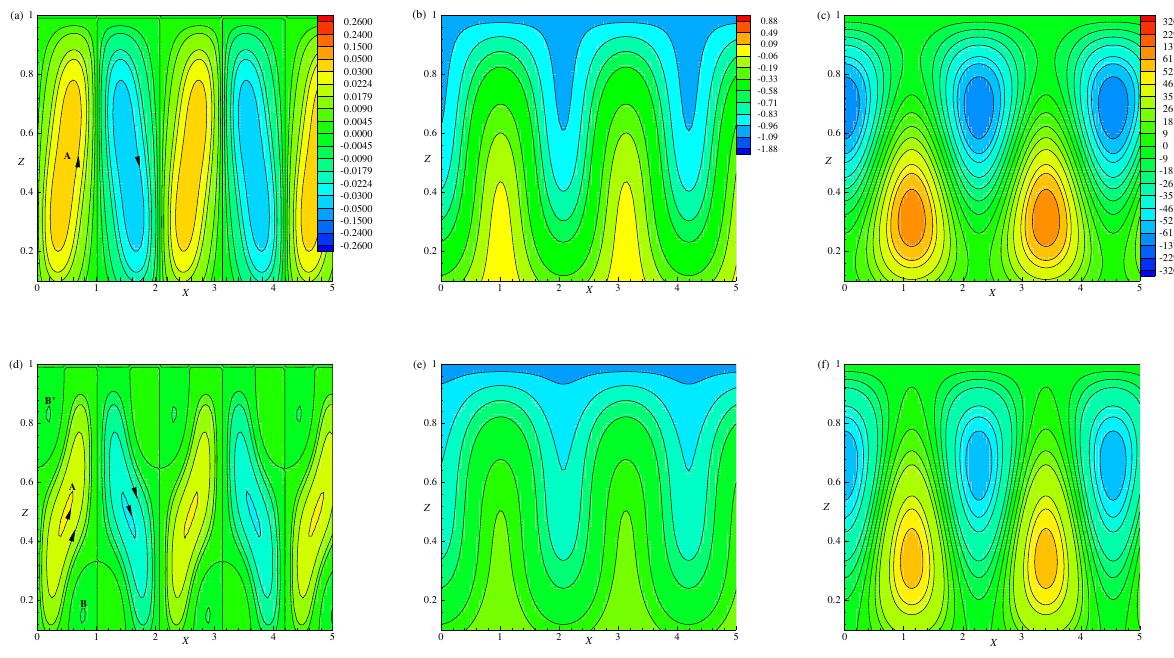
of streamlines are tilted towards the right side by retaining the flow orientation in the considered range of 0 ≤ X ≤ 1. The absolute maximum and minimum values of circulation strength are 0.03585 and − 0.03585, respectively. Figure 9d–f are plotted for ψ = − 0.03, with the same fixed set of parameters and contour lines defined in Figure 9a–c. In Figure 9d, the flow pattern in the range 0 ≤ X ≤ 1 becomes more deformed by creating the two additional vortices B and B (cid:48) at the top and bottom limits, respectively, and on either side of the primary cell. The circulation strength of the two vortices, B and B (cid:48) is − 0.012. In the area, 0 ≤ X ≤ 1, circulation strength has absolute maximum and minimum values of 0.03556 and − 0.03555, respectively. From Figure 9a,d, we can observe that the streamline deformation is increased when ψ values decrease. This implies that the effect of an increase in ψ values stabilizes the convective system. The flow of heat transfer is depicted using the isotherms and is shown in Figure 9b,e for ψ = − 0.02 and − 0.03, respectively. The isotherms appeared as plumes in the range of 0 ≤ X ≤ 5, as shown in Figure 9b. The boundary layer thickness increased when ψ decreased from − 0.02 to − 0.03. The isoconcentrations (concentration field) are plotted in Figure 9c,f for ψ = − 0.02 and − 0.03, respectively. The isoconcentrations occurred in the form of vortices in the range of 0 ≤ X ≤ 5. The size of vortex structures increased as ψ decreased. The boundary layer of the concentration region increases as ψ decreases from − 0.02 to − 0.03. For a particular ψ value, the distribution of the concentration field is higher than the temperature field due to Soret effect.